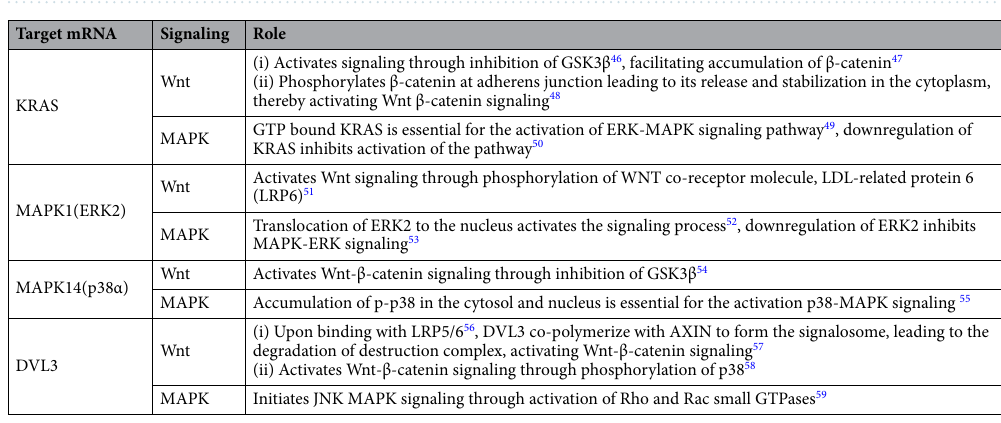
Table 1. Role of the predicted targets of hsa-miR-143-3p in Wnt and MAPK signaling.